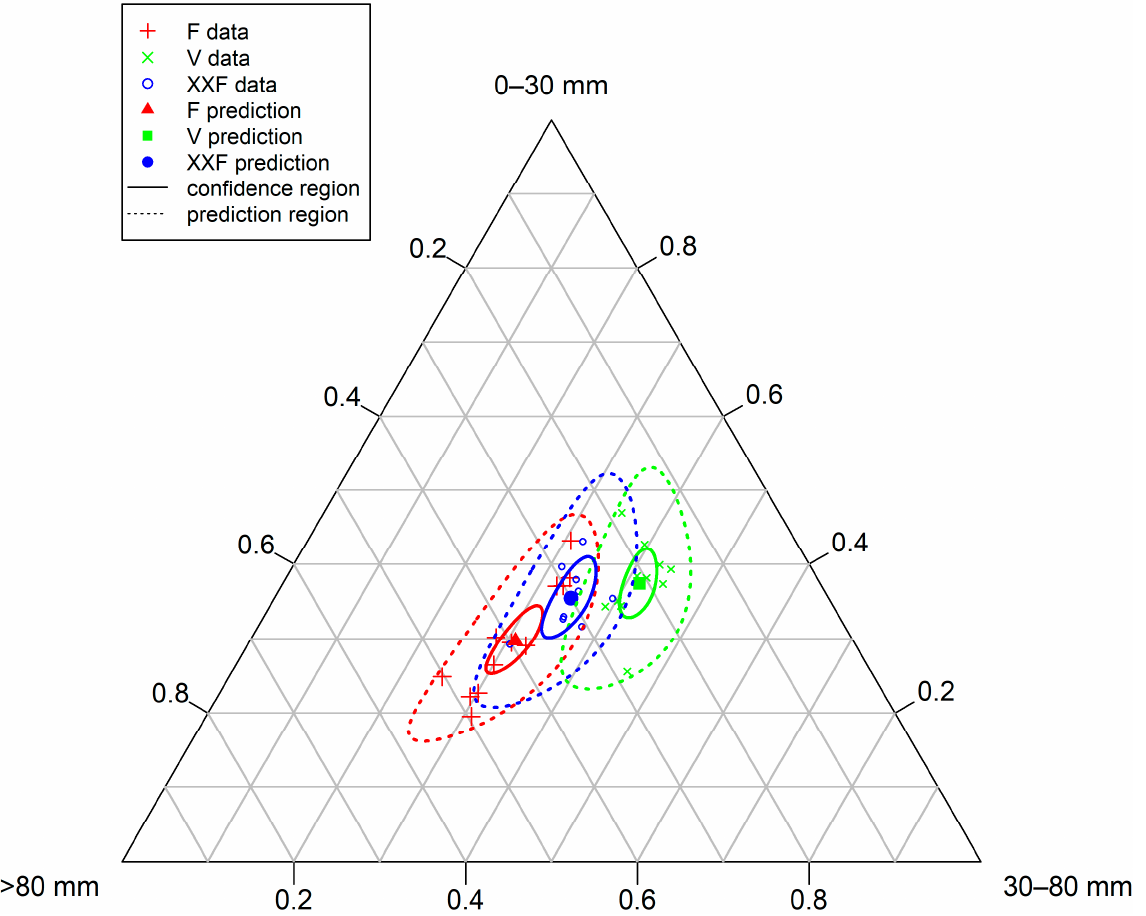
Figure 4. Prediction values and confidence and prediction regions for the particle size class distributions resulting from different cutting tool geometries.